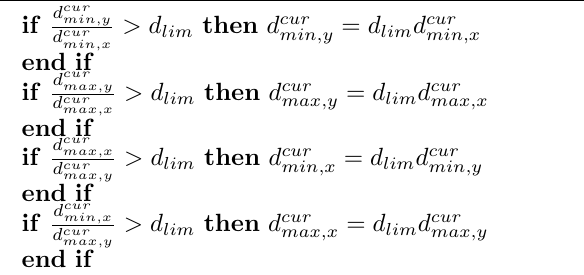
Algorithm 2 Interval narrowness